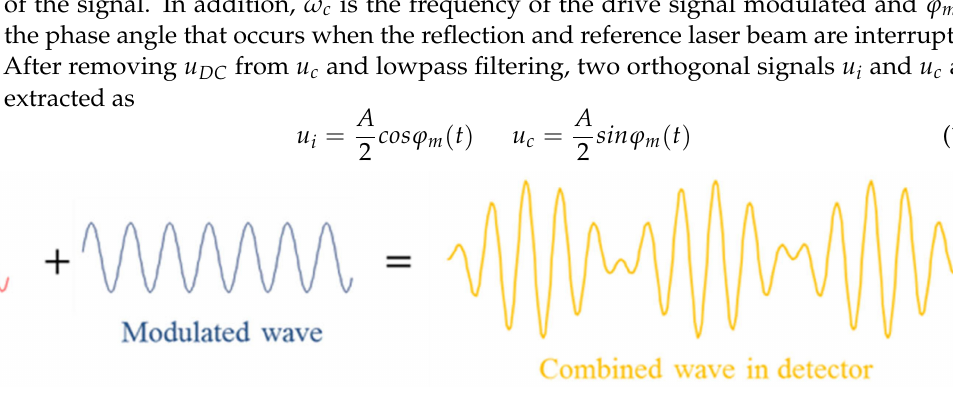
Figure 4. Detected laser at